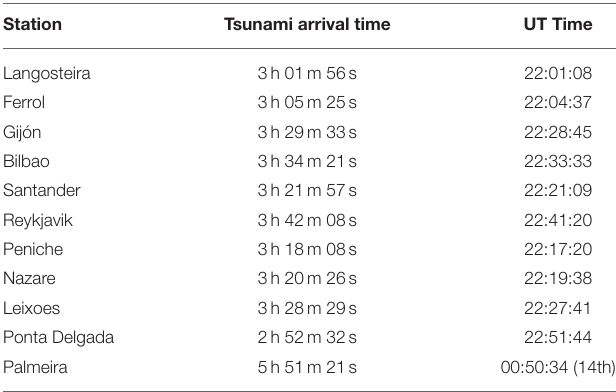
TABLE 2 | Estimated arrival times of the first tsunami wave from numerical simulations of the earthquake of February 13th, 2015 in the Atlantic ridge.